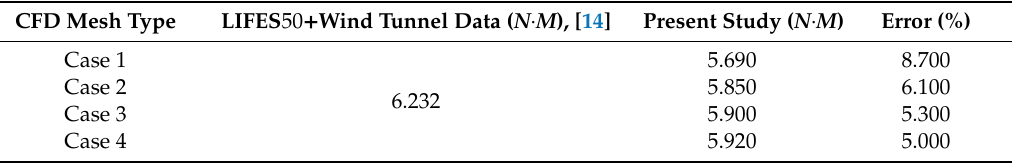
Table 4. Comparison of torque between experiment and CFD simulation at different grid densities.